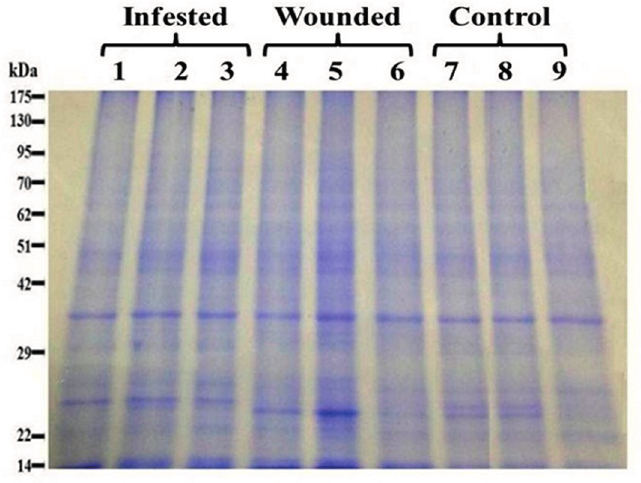
Figure 1. Comparative protein expression profiling of the control, infested and wounded date palm samples using SDS-PAGE. Lanes 1–3 represent total cell proteins from 3-infested replicates; while lanes 4–6 represent proteins from wounded date palm samples; and lanes 7–9 represent proteins from control date palm